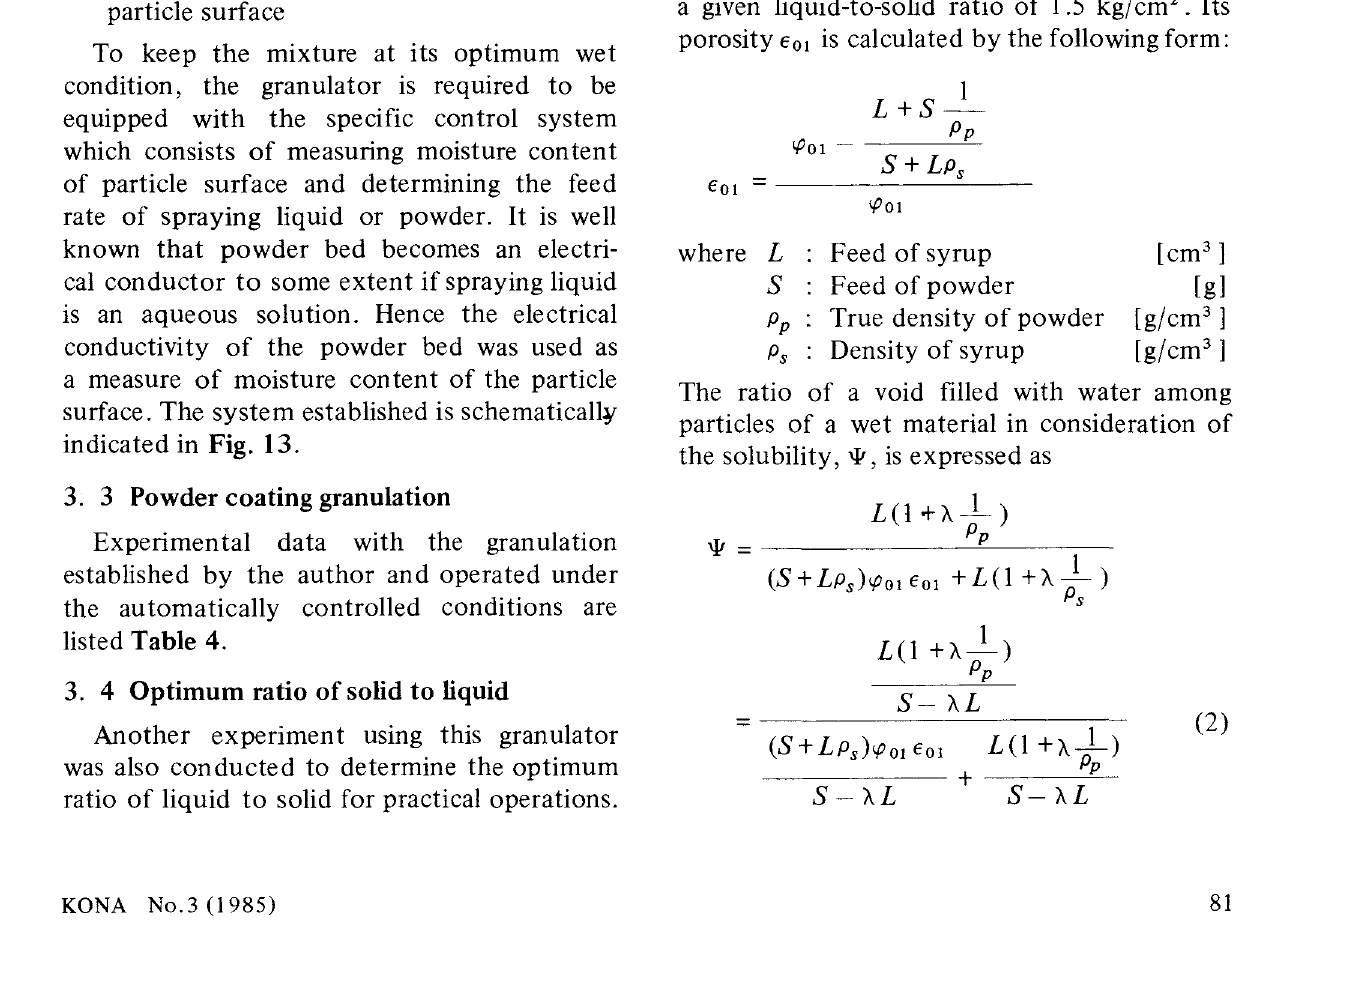
Fig. 12 Operating condition for spray vs. formation percentage of coagulated particles